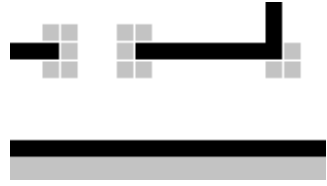
Fig. 11. Regions to avoid during planning are marked in gray and walls in